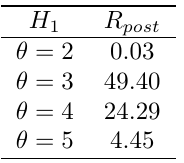
Values of R post with different alternative